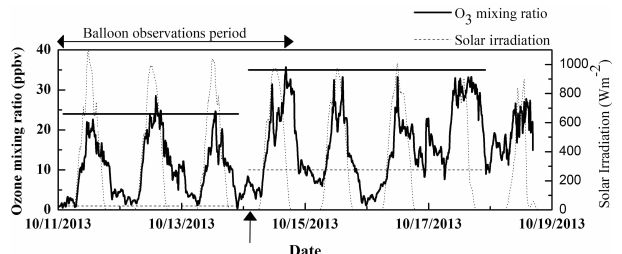
Figure 4. Time series of surface ozone mixing ratio (thick line) along with solar radiation (dotted line) from 00:00IST on 11 Oc- tober 2013 to 23:55IST on 19 October 2013. Solid and dotted hor- izontal lines indicate the mean maximum and minimum surface ozone. The vertical arrows indicate the nocturnal enhancement of surface ozone. The data is collected with 5min